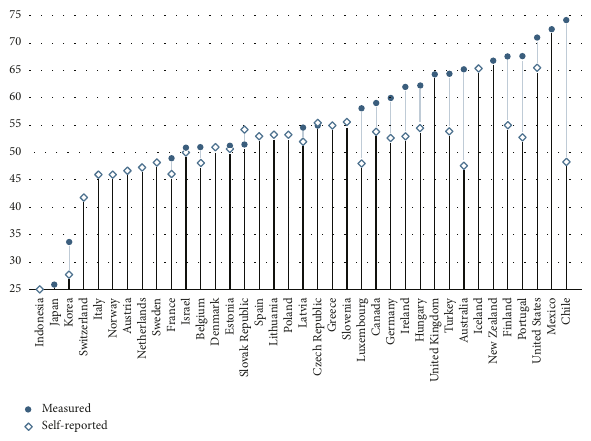
Figure 1: Overweight or obese population (measured/self-reported % of population aged 15+, 2018 or latest available). Source: OECD report available at https://data.oecd.org/pinboard-editor/ (Last accessed on June 30, 2021). Overweight is defined as 25 ≤ BMI < 30, and obesity is defined as BMI ≥ 30, where BMI � kg/meter 2